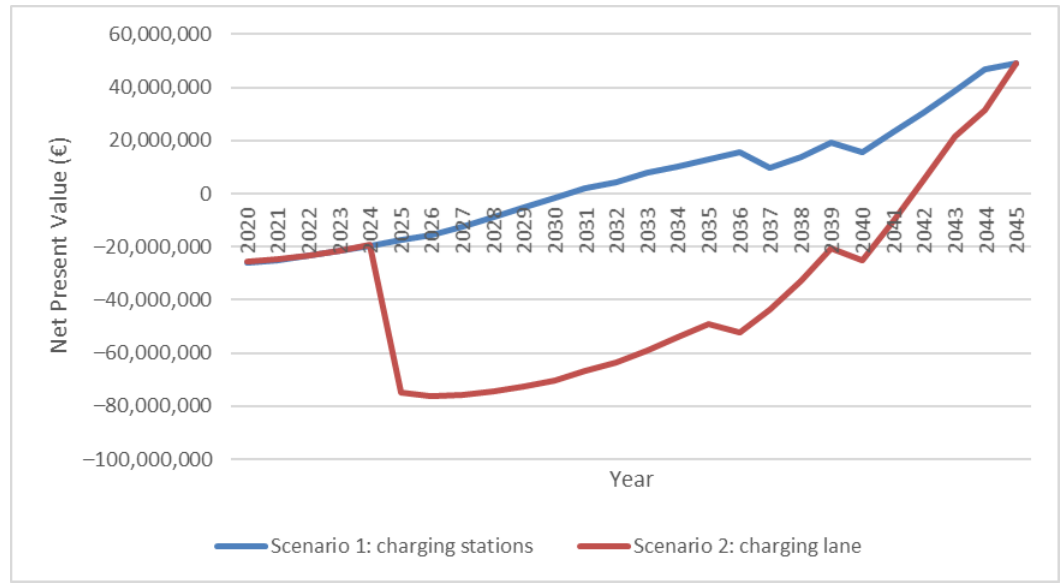
Figure 2. Evolution of the net present value of the charging infrastructure.